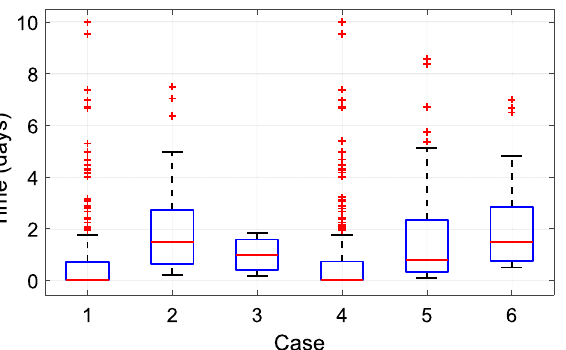
Figure 16. Boxplots of times between the first and last missed cycles in each